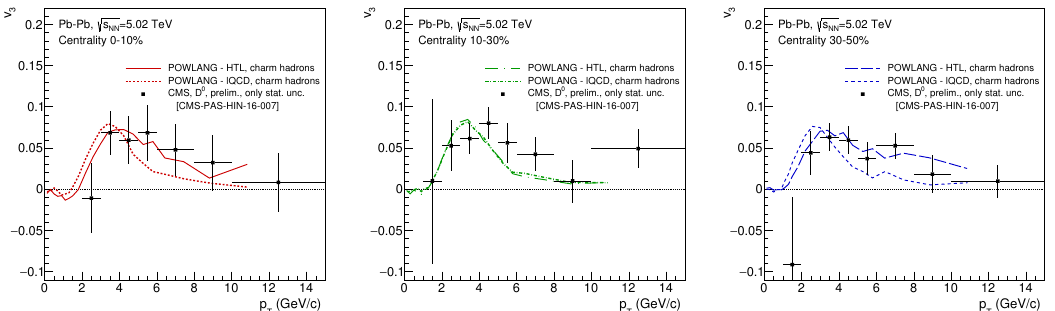
p s NN = 5 : 02 TeV, for vari-